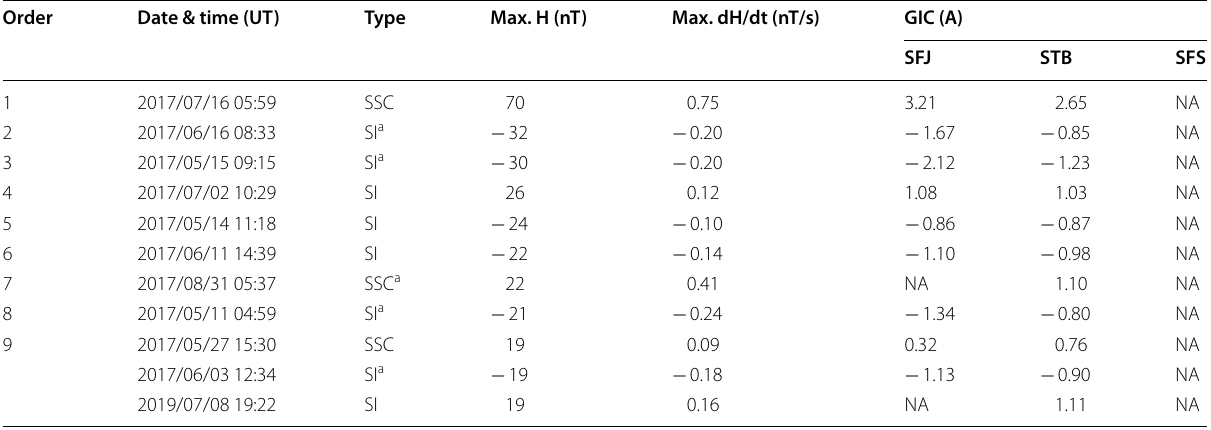
Table 4 SSCs/SIs with largest values of H-component geomagnetic field reported from KAK and maximum GICs associated with them